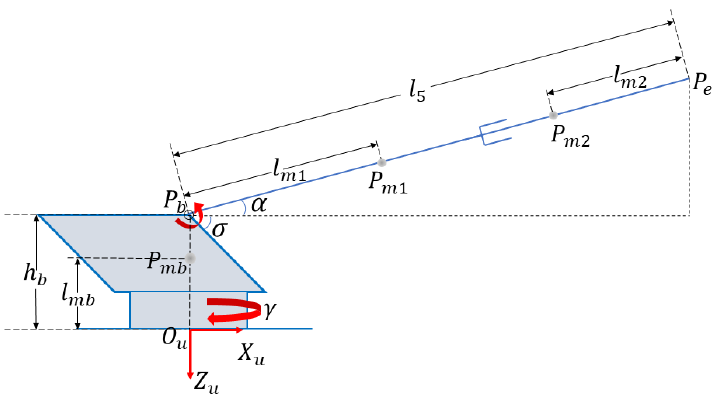
Figure 3. Dimensions of the transfer gangway and frames of the slewing mechanism.